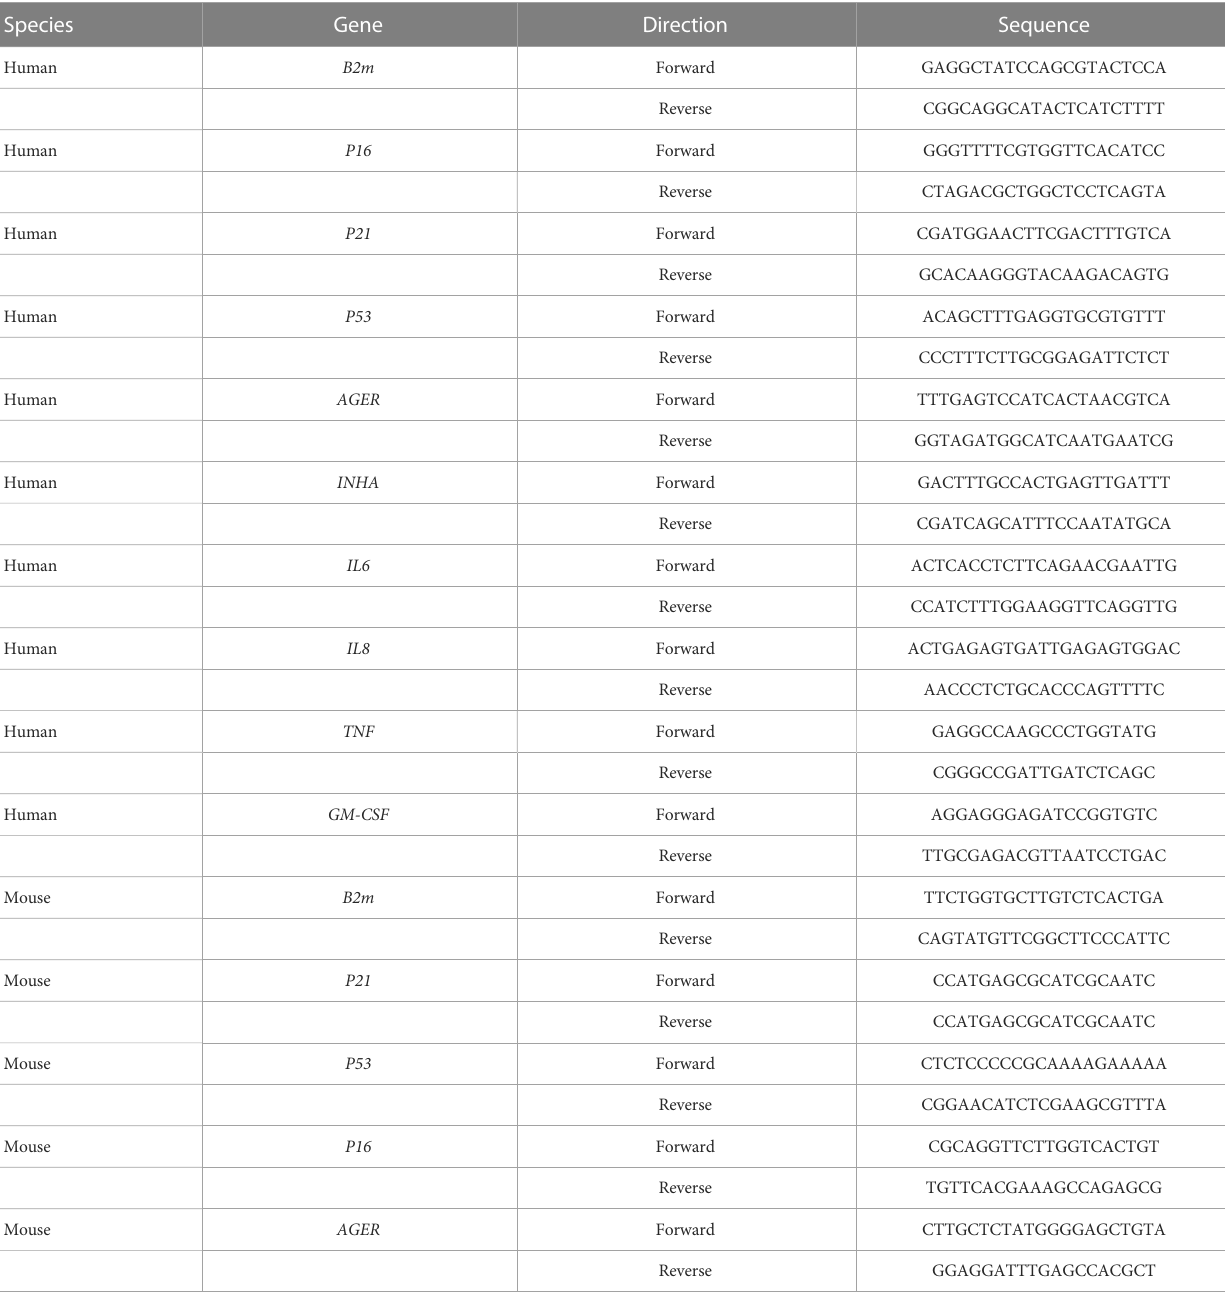
indicate a signi fi cant difference. Symbols for statistical signi fi cance